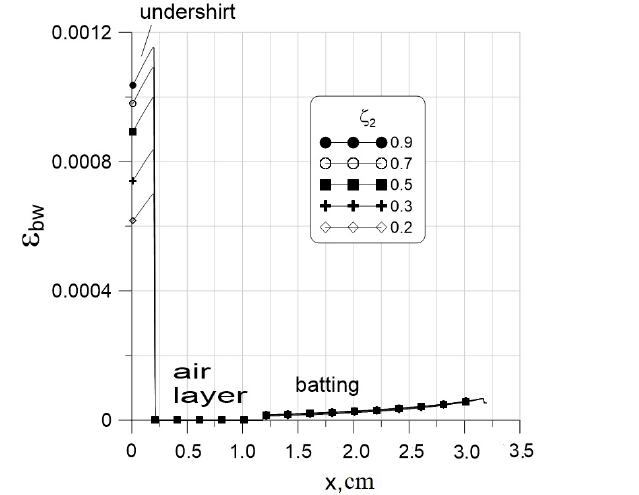
Figure 10. Influence of the IR on the bound water content in